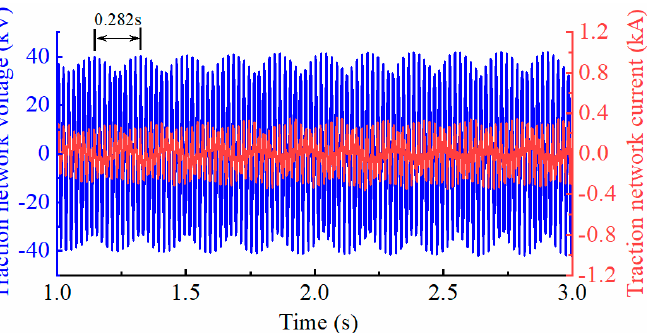
Figure 17. Grid-side voltage and current waveforms when a single HXD 2B vehicle was connected.